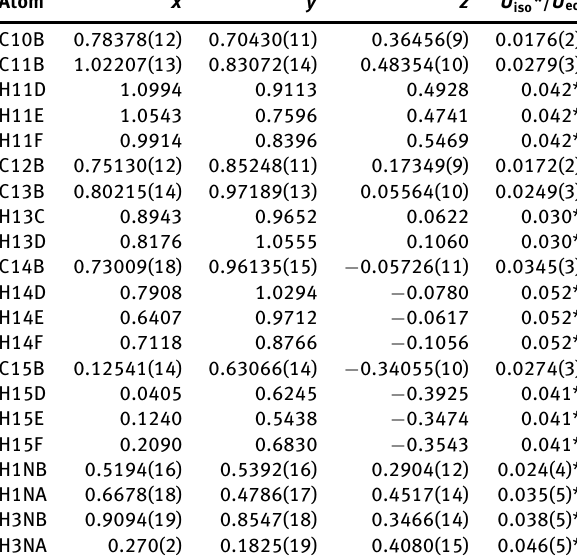
Table 2: Fractional atomic coordinates and isotropic or equivalent isotropic displacement parameters (Å 2